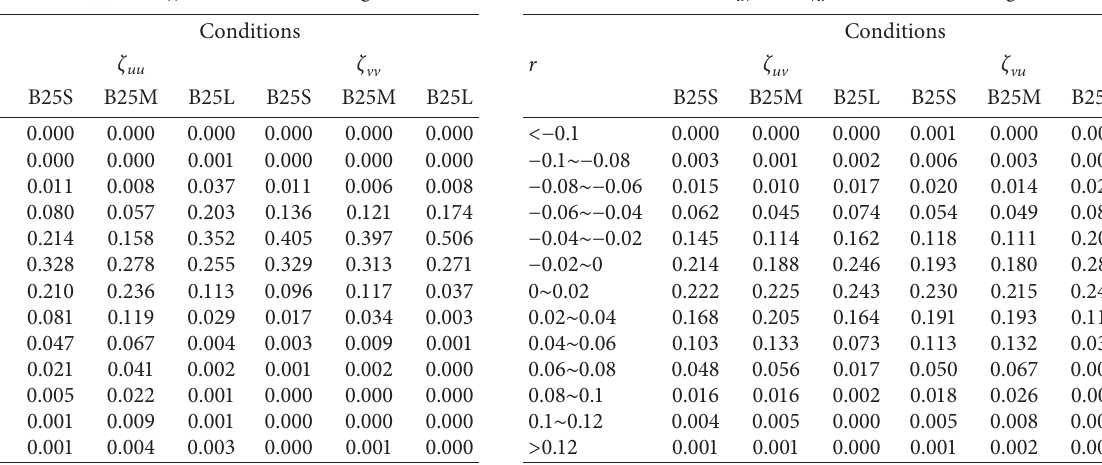
Figure 8: The distribution of C vv in different working conditions. (a) B25S. (b) B25M. (c) B25L. Table 3: The value of ζ Table 4: The value of ζ uv and ζ vu in different working uu and ζ vv in different working conditions.